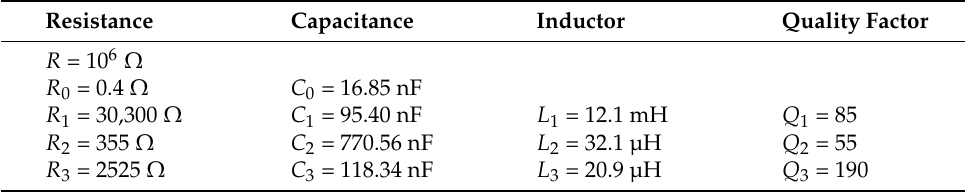
Figure 15. Equivalent circuit model of PZT-27 without mechanical load. Table 3. Model parameters for PZT-27 without mechanical